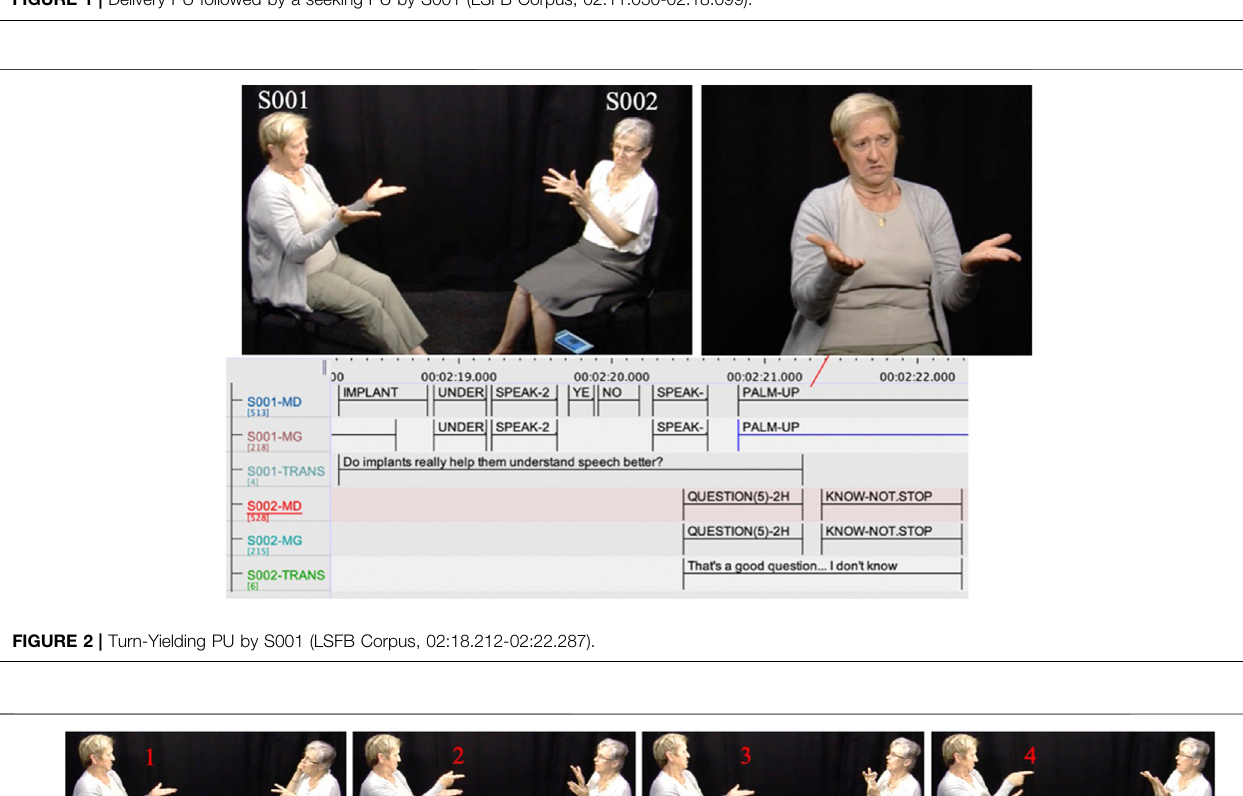
Frontiers in Communication |